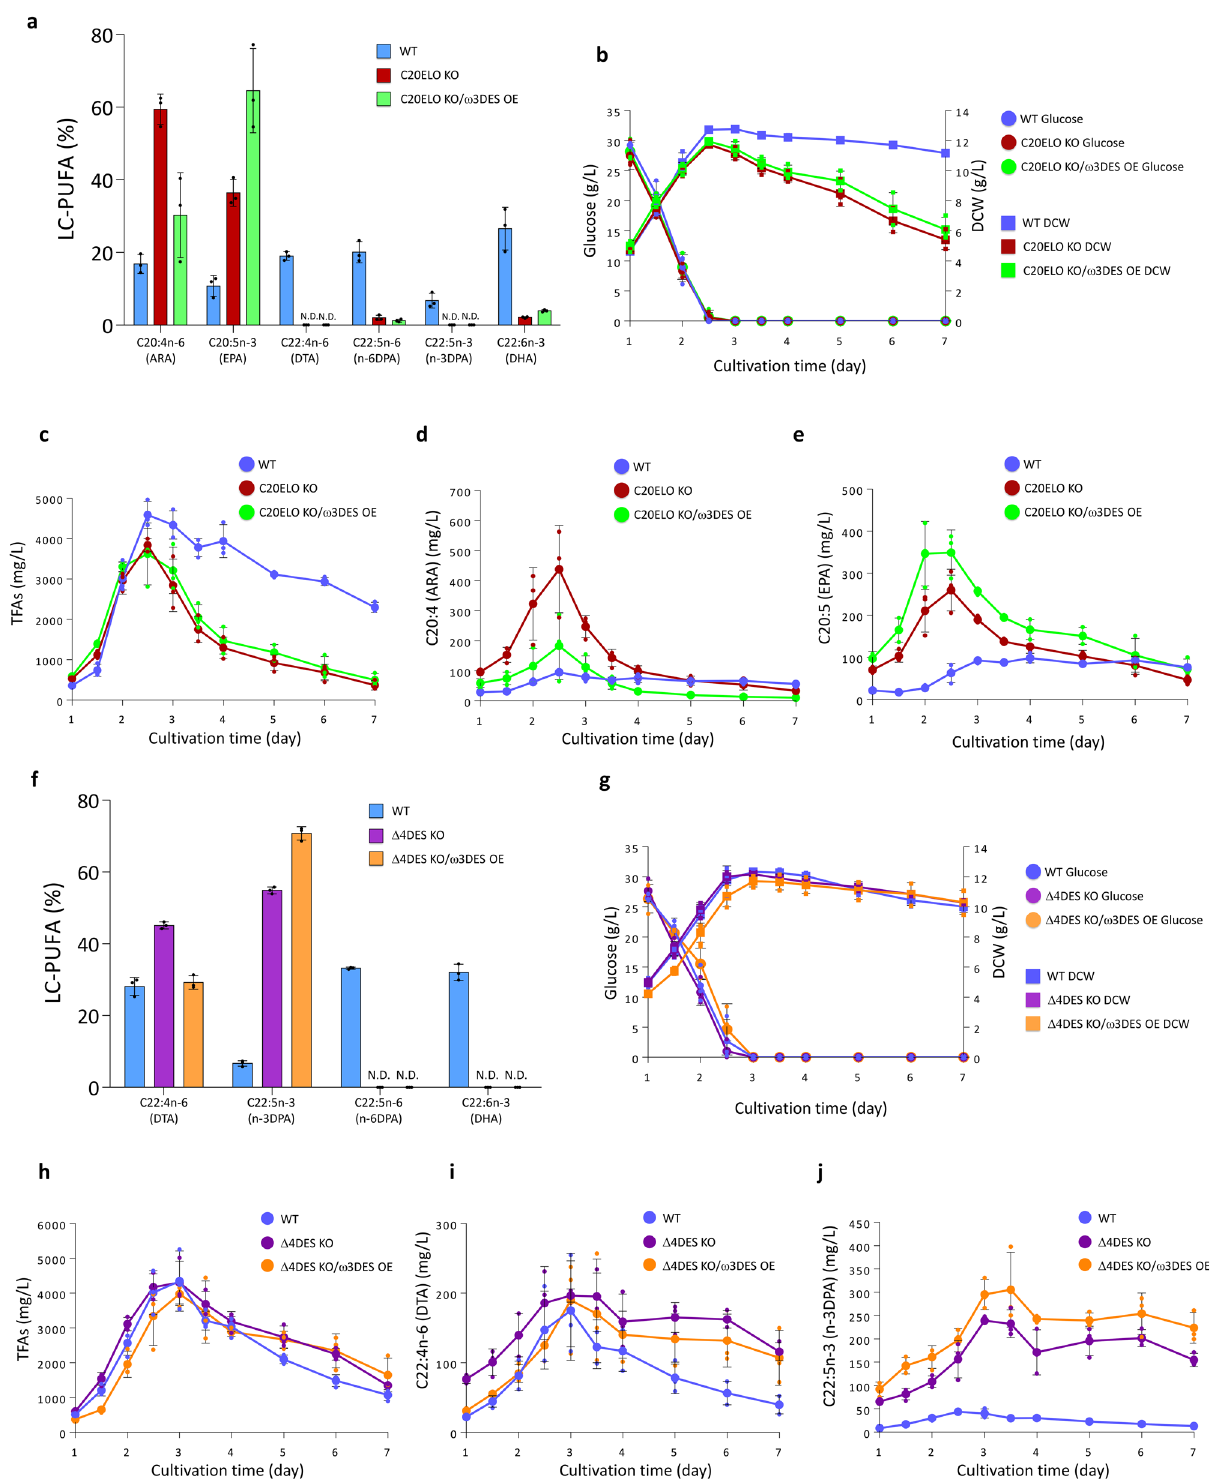
Fig. 2 Production of EPA and n-3DPA by genetic manipulation of Parietichytrium sp. a LC-PUFA pro fi les of WT, C20ELO KO, and C20ELO KO/ ω 3DES OE of Parietichytrium sp. in fl ask culture. Fatty acids were extracted from the 2-day cultured Parietichytrium sp. and used for GC analysis. b Growth characteristics of each strain. Glucose consumption and DCW were measured. c Time course of TFA production in each strain. d Time course of the production of C20:4n-6 (ARA) in each strain. e Time course of the production of C20:5 (EPA) in each strain. f LC-PUFA pro fi les of WT, Δ 4DES KO, and Δ 4DES KO/ ω 3DES OE of Parietichytrium sp. in fl ask culture. Fatty acids were extracted from the 3-day cultured Parietichytrium sp. and used for GC analysis. g Growth characteristics (glucose consumption and DCW) of each strain. h Time course of TFA production in each strain. i Time course of the production of C22:4n-6 (DTA) in each strain. j Time course of the production of C22:5n-3 (n-3DPA) in each strain. All data shown are the mean ± SD. ( n = 3). The n values are numbers of replicates. WT, C20ELO KO, C20ELO KO/ ω 3DES OE, Δ 4DES KO, and Δ 4DES KO/ ω 3DES OE strains used in fl ask culture were derived from Parietichytrium sp.